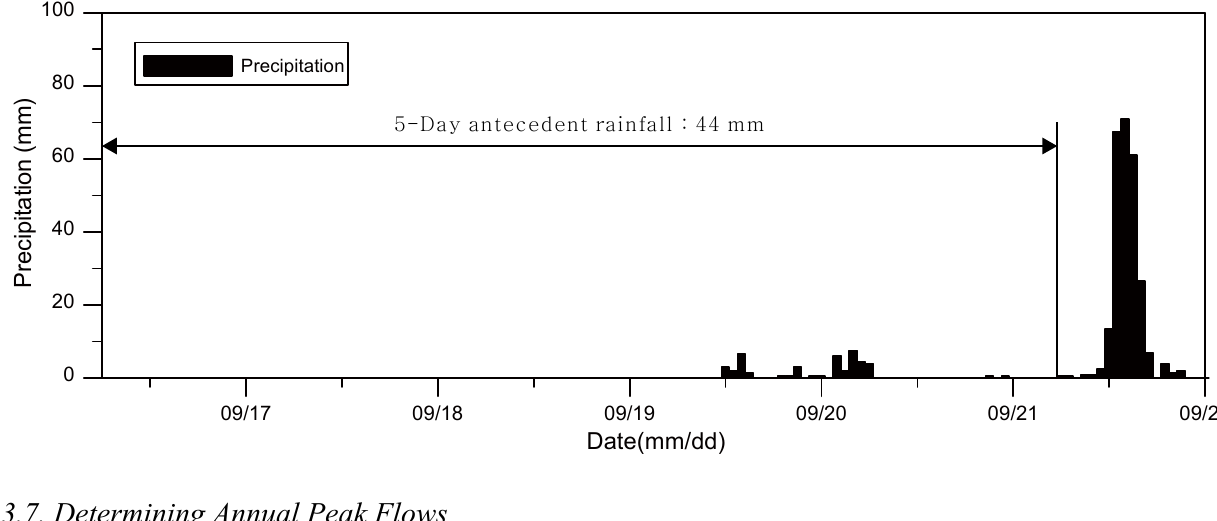
Figure 9. Rainfall hyetograph of candidate event and previous 5-day in